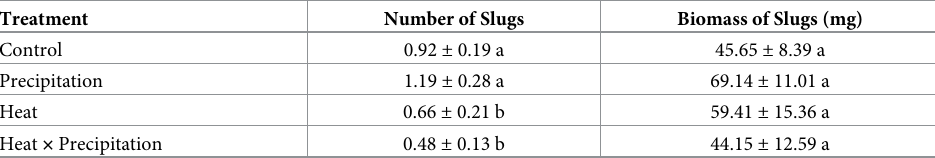
Table 2. Average number and estimated biomass ( ± S.E.) of slugs caught per plot by climate treatment across all 20 trapping events. Letters indicate significant differences across climate treatments. Treatment